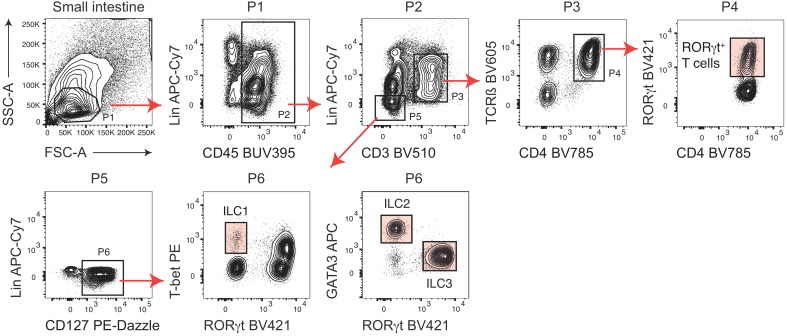
Gating strategy to identify intestinal ILC1s, ILC2s, ILC3s and RORγt+ T cells.Representative flow cytometric staining of siLP cells with different lineage-defining surface markers and transcription factors. ILCs were defined as CD45+ Lineage- (Lin-) CD3- CD127+ cells. ILC1s were additionally defined as RORγt- T-bet+, ILC2s as RORγt- GATA3+ and ILC3s as RORγt+. Lineage includes anti-B220, anti-Gr1, anti-FcεRIα, anti-F4/80, anti-CD11c, anti-CD11b and anti-CD5. RORγt+ T cells were pregated on CD45+ CD3+ CD4+ TCRß+ cells.